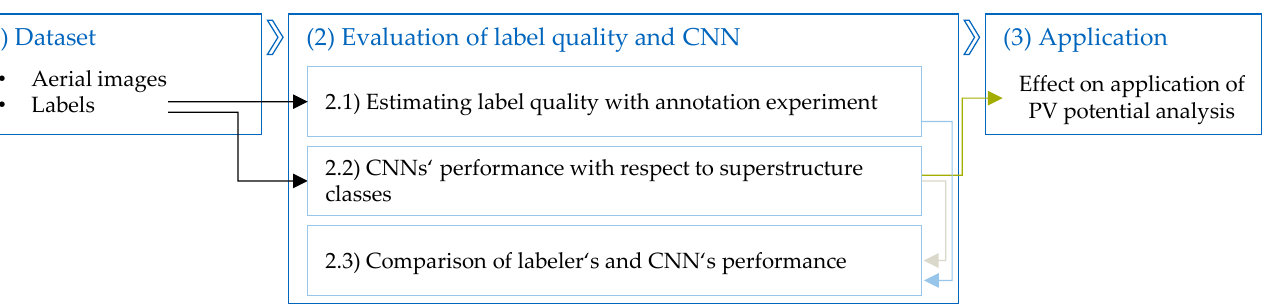
Figure 1. Graphical abstract depicting the three steps in this paper: description of the roof information dataset; evaluation of the label quality and convolutional neural network (CNN); the application of semantic segmentation of superstructures for PV potential analysis.